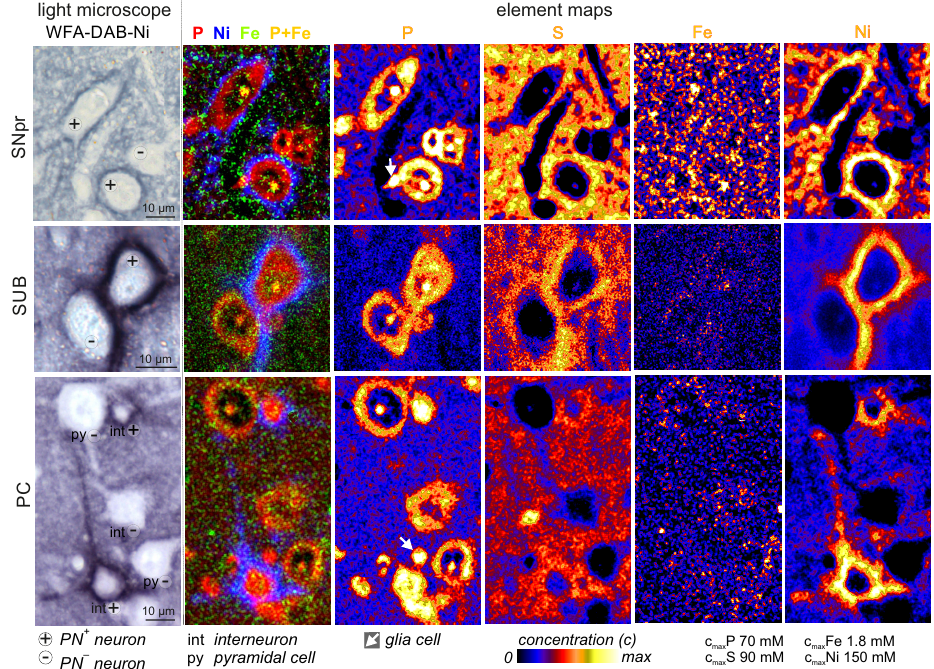
Figure 1. Quantitative element maps of groups of PN + and PN – neurons in the rat brain regions parietal cortex (PC), subiculum (SUB), and substantia nigra pars reticulata (SNpr). PNs appear in the nickel map due to Ni-DAB-enhanced WFA-staining. Intracellular iron concentrations were extracted from manually drawn